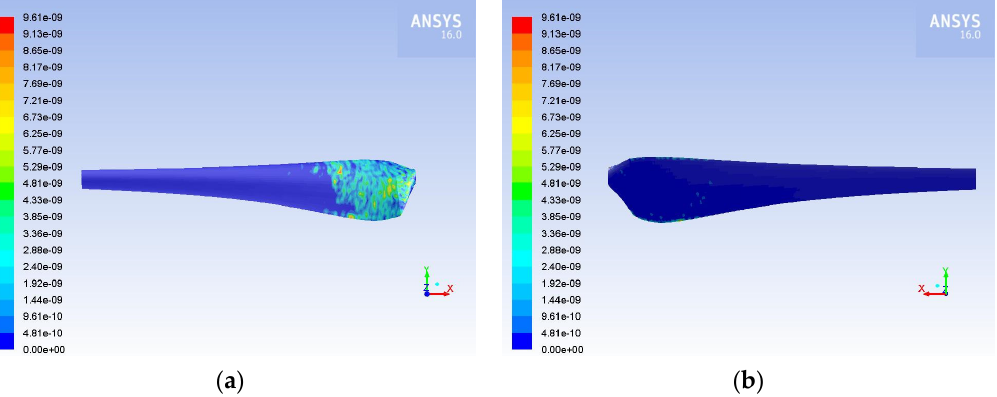
Figure 15. Erosion rate on ( a ) the pressure; ( b ) the suction side of the blade for hailstorm conditions and air velocity equal to 15 m·s − 1 .